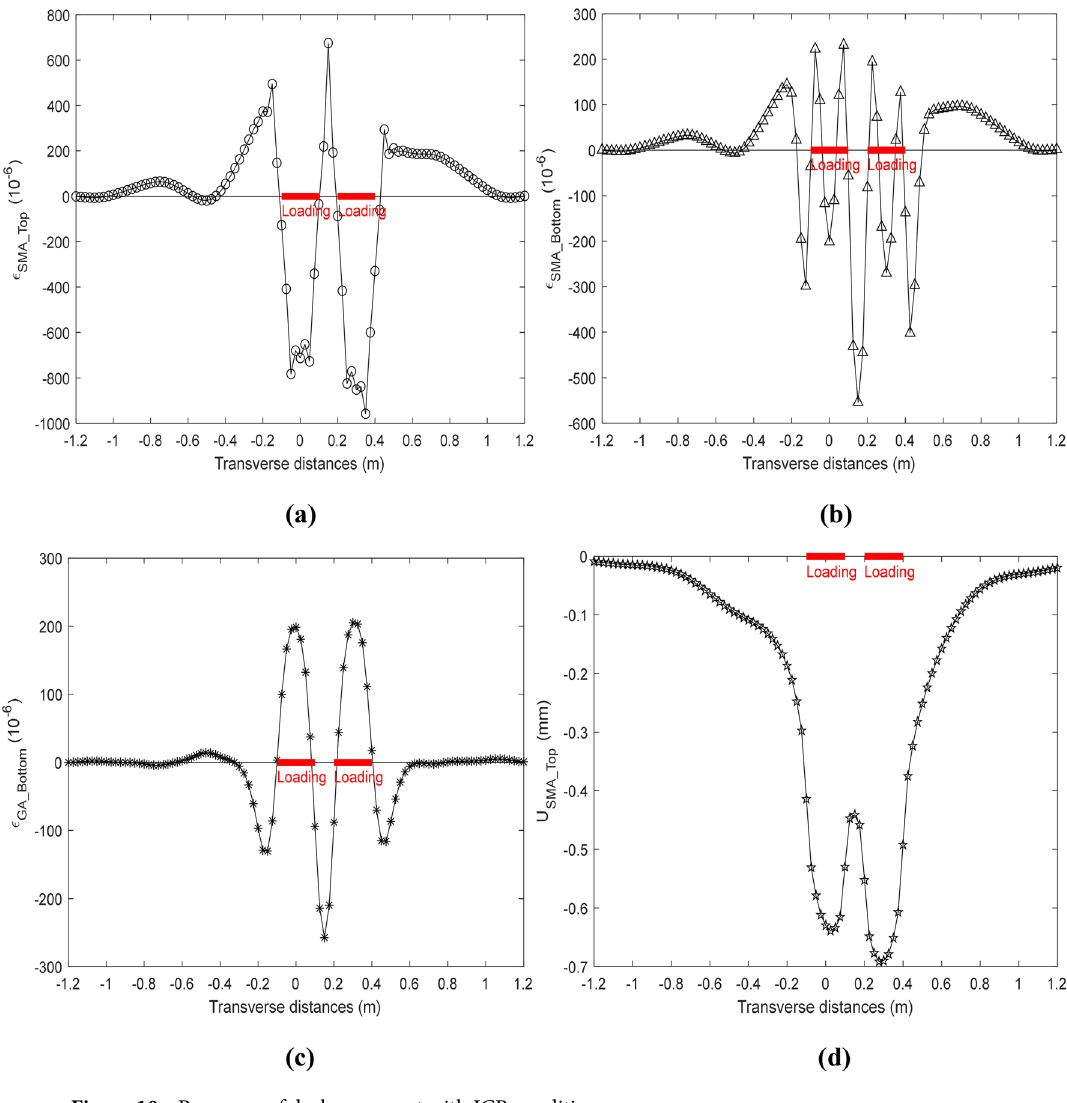
Figure 10. Response of deck pavement with ICB condition.